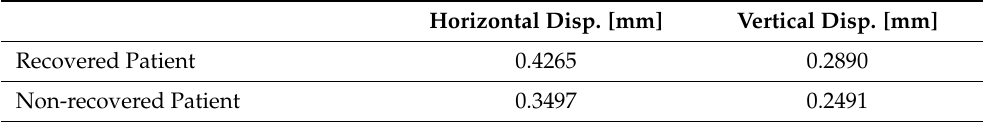
Figure 3. Displacements suffered by the retina, after the membrane remotion. The arrows show the amount of displacement. Table 3. Maximum retinal displacements for the recovered and non-recovered